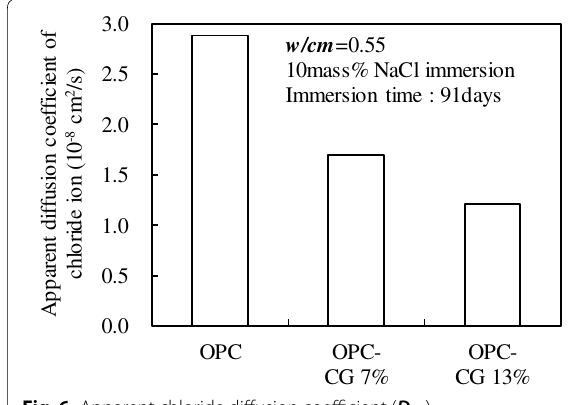
Fig. 6 Apparent chloride diffusion coefficient ( D ap